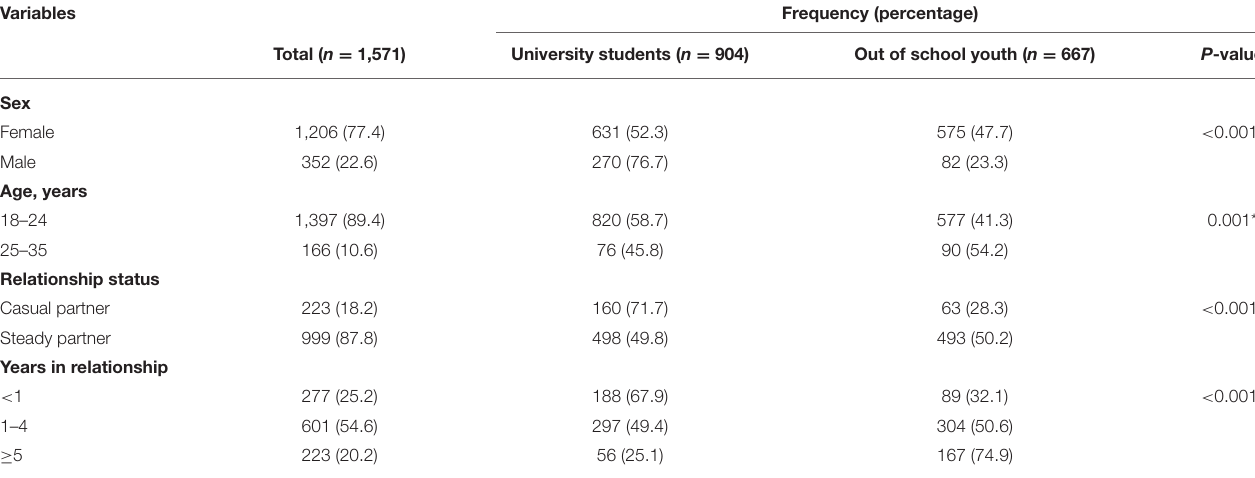
TABLE 1 | Demographic characteristics of the youth by